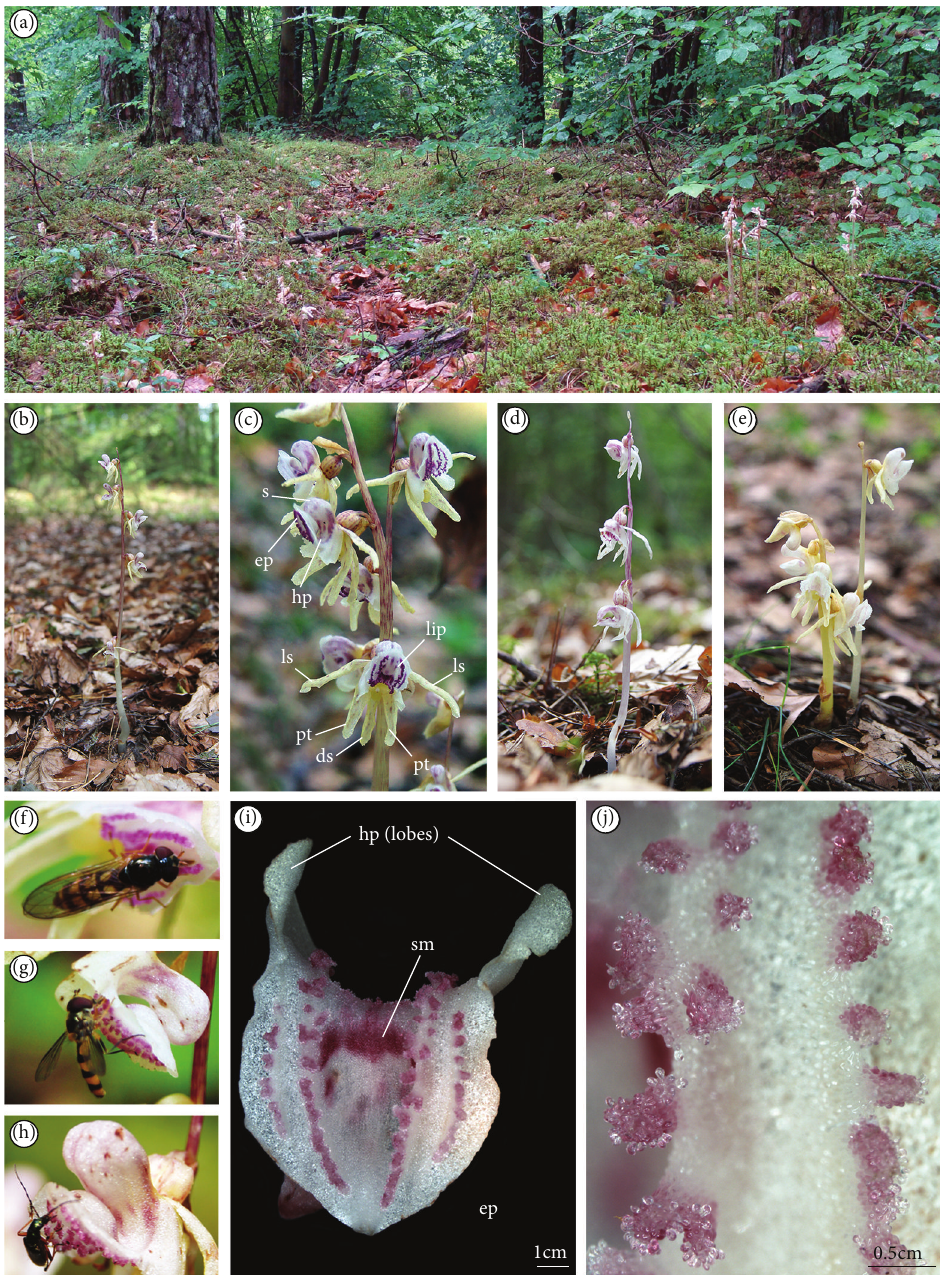
Figure 1: Epipogium aphyllum : (a) habitat in Dar˙zlubska Forest, (b) normal blooming shoot, (c) inflorescence of normal blooming shoot, (d) half-albino blooming shoot (without yellow pigment), and (e) half-albino blooming shoot (without pink pigment). Visiting insects licking the fluids on the lip: (f, g) Meliscaeva cinctella and (h) Chrysanthia geniculata . (i) Lip epichile with four pink papillate ridges leading to the upwardly located spur and central furrow with pink smudge ( sm ); hypochile with two lateral lobes (LM). (j) Multicellular outgrowths on ridges consisted of groups of rounded papillae (LM) (ds: dorsal sepal, ls: lateral sepal, pt: petal, lip with hp–hypochile and ep–epichile, s: spur, and sm; pink smudge on